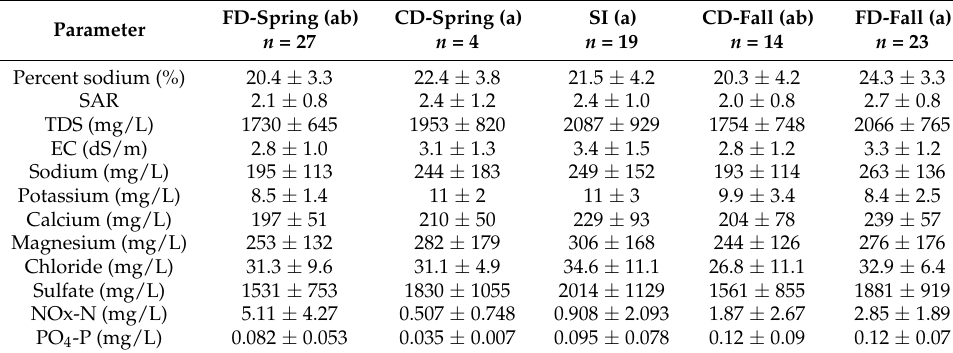
Table 4. Downstream ditch water mean values for percent sodium, sodium adsorption ratio (SAR), total dissolved solids (TDS), electrical conductivity (EC), and chemical concentrations for sodium, potassium, calcium, magnesium, chloride, sulfate, nitrite + nitrate nitrogen NOx-N, and orthophos- phate (PO 4 -P) in 2012–2018 during free drainage (FD), controlled drainage (CD), and subirrigation (SI) periods. Significant differences as determined by Tukey’s Honestly significant difference post hoc test with an alpha value of 0.05 are shown by different letters. Sample size ( n ) is given below each column title and standard deviations are listed for each